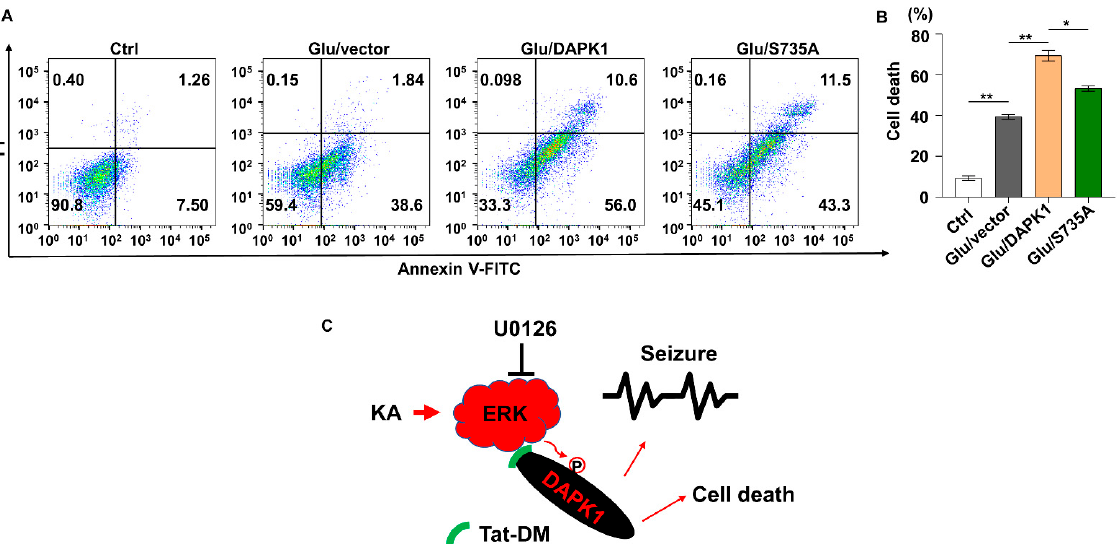
Figure 8. Increased glutamate-induced apoptosis is alleviated by the DAPK1 mutant. ( A , B ) Flag- Vector, Flag-DAPK1, or Flag-DAPK1-S735A was transfected into SH-SY5Y cells for 36 h followed by 10 mM glutamate treatment, and then the apoptosis rate was measured 24 h after glutamate incubation by flow cytometry (* p < 0.05, ** p < 0.01; one-way ANOVA with Tukey’s multiple comparisons test). All data represent the mean ± SD of three independent experiments. ( C ) Schematic representation of the proposed model of the ERK-DAPK1 axis in neuronal injuries induced by glutamate